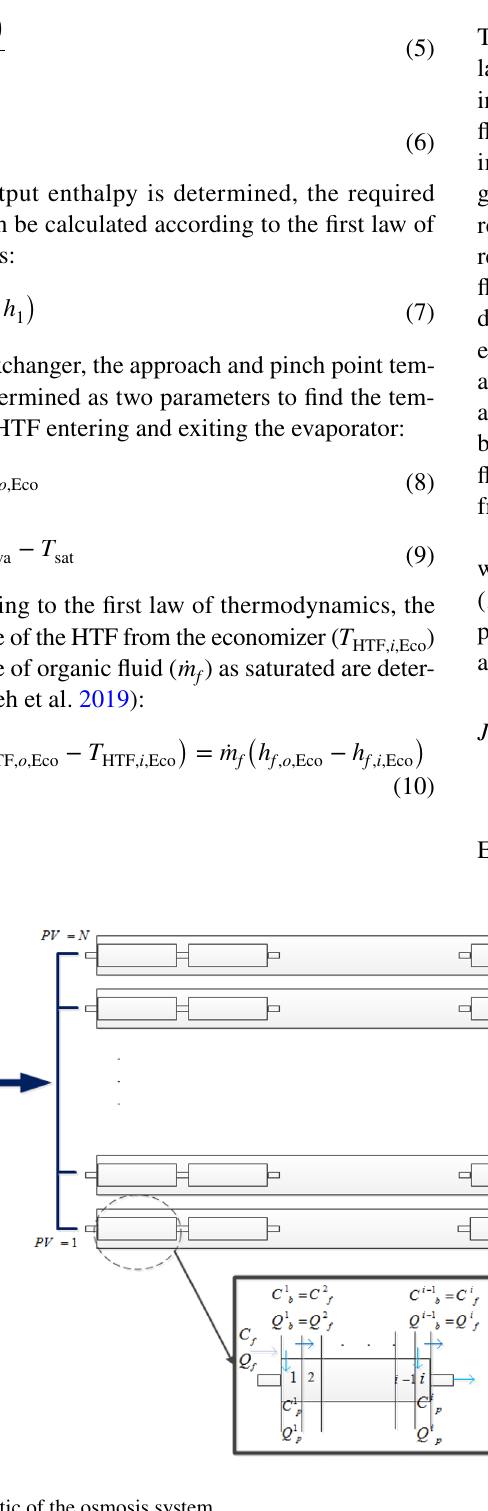
Fig. 3 The schematic of the osmosis